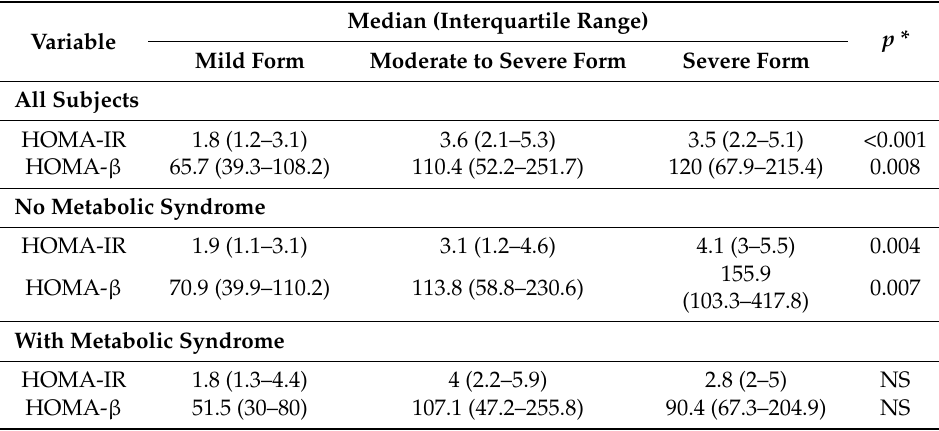
Table 3. HOMA-IR and HOMA- β according to disease